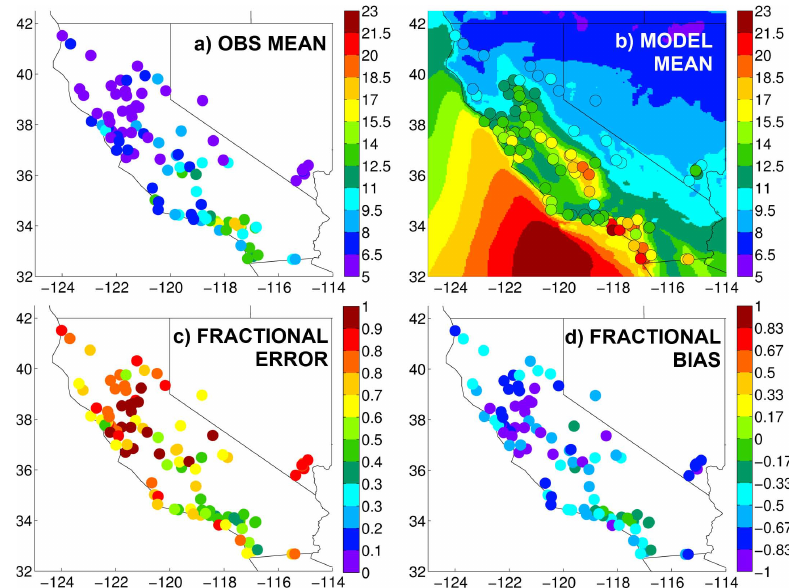
Fig. 2. Non-assimilated model evaluation against PM 2 . 5 monitors from AQS network throughout California and Nevada for May 2010. Panels show Observation mean (a) , model map and model masked to observations means (b) , fractional error (c) and fractional bias (d) .